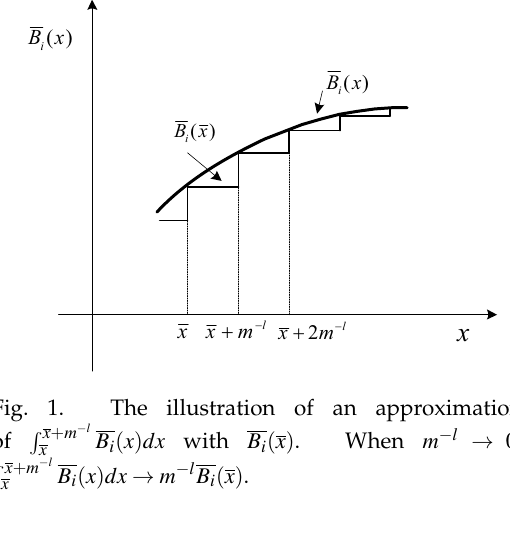
Fig. 1. The illustration of an approximation (cid:2) x + m − l B i ( x ) dx with B i ( x ) . When m − l → 0 , of x (cid:2) x + m − l B i ( x ) dx → m − l B i ( x ) x